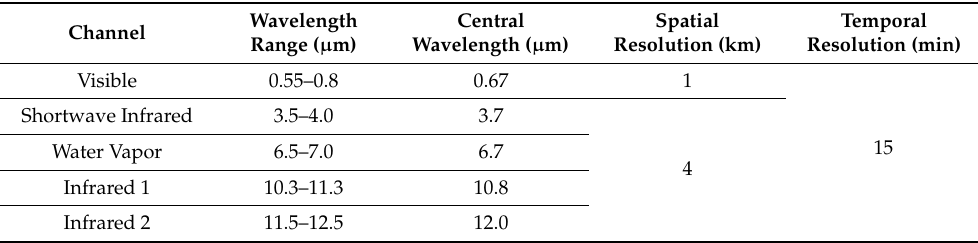
Table 1. Specifications of the Communication, Ocean and Meteorological Satellite Meteorological Imager sensor. Water vapor and infrared 1 channels were used for tropical cyclone center estimation in this study.